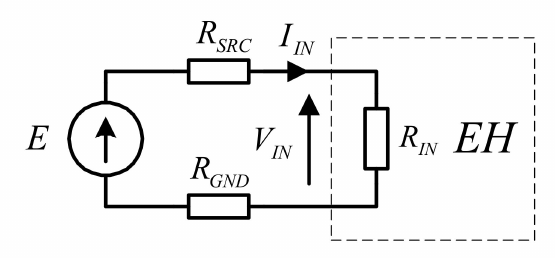
Figure 2. The simplified input circuit of the energy harvesting